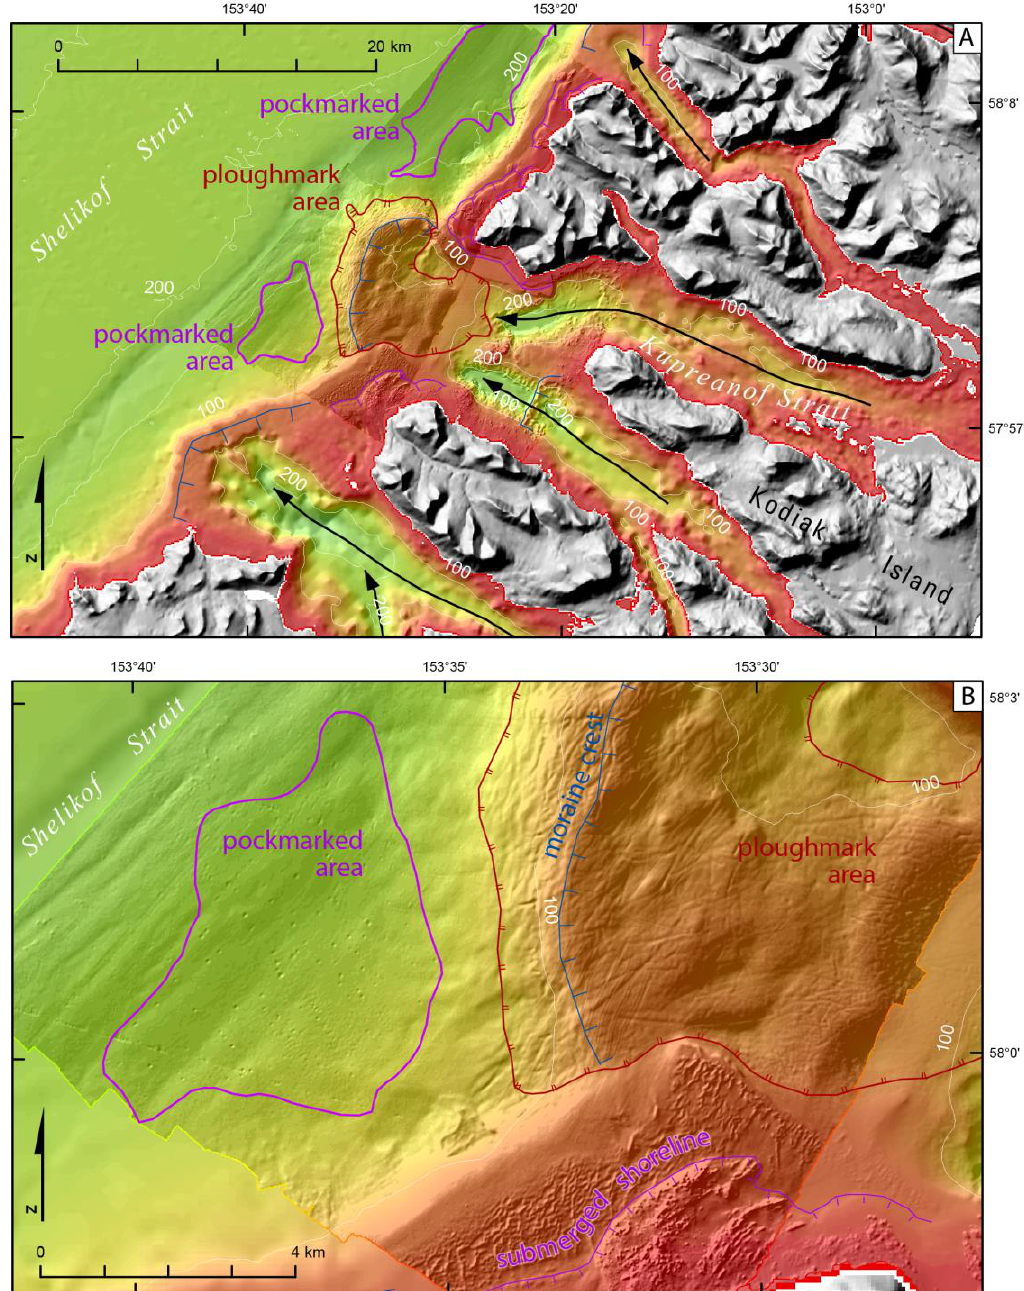
Figure 9. ( A ) Overview map of the west end of Kupreanof Strait and part of Shelikof Strait with 25 m contours. The location of the figure is shown on Figure 5 and the symbology is the same as Figure 5. This figure shows how we mapped glacier flow directions (black lines with arrowheads) down the axes of fjords. It also shows how moraine crests (blue hatchured lines) can be mapped on both high resolution and low-resolution data. Pockmarked areas (pink lines), areas with iceberg ploughmarks (red double hachured-lines), and a submerged shoreline (pink hachured line) are also shown. See text for more discussion of these features. ( B ) Expanded view of moraine at mouth of Kupreanof Strait, showing how iceberg ploughmarks extend over the crest of the moraine. Also, note the area of circular pockmarks to the west, as well as the submerged shoreline close to 50 m water depth at the bottom.